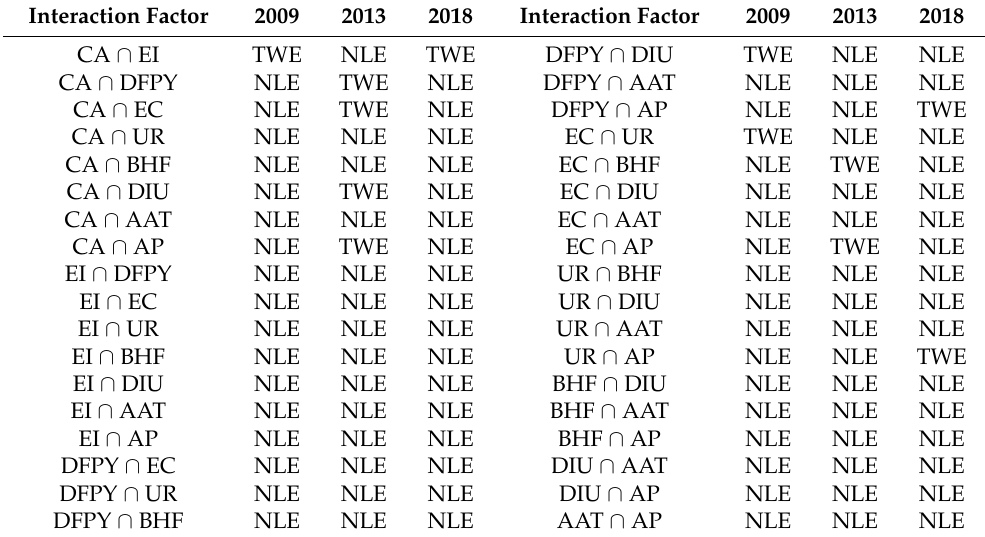
Table 5. Factor interaction detection results in 2009, 2013,